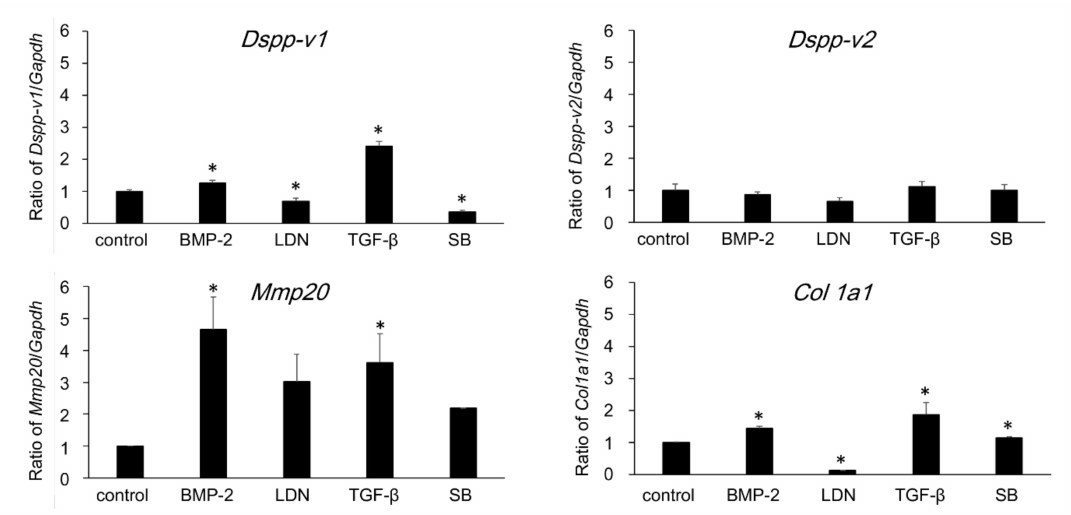
Figure 7. E ff ect of BMP-2, TGF- β 1, LDN-193189 and SB-431542 on the expression of the odontoblastic